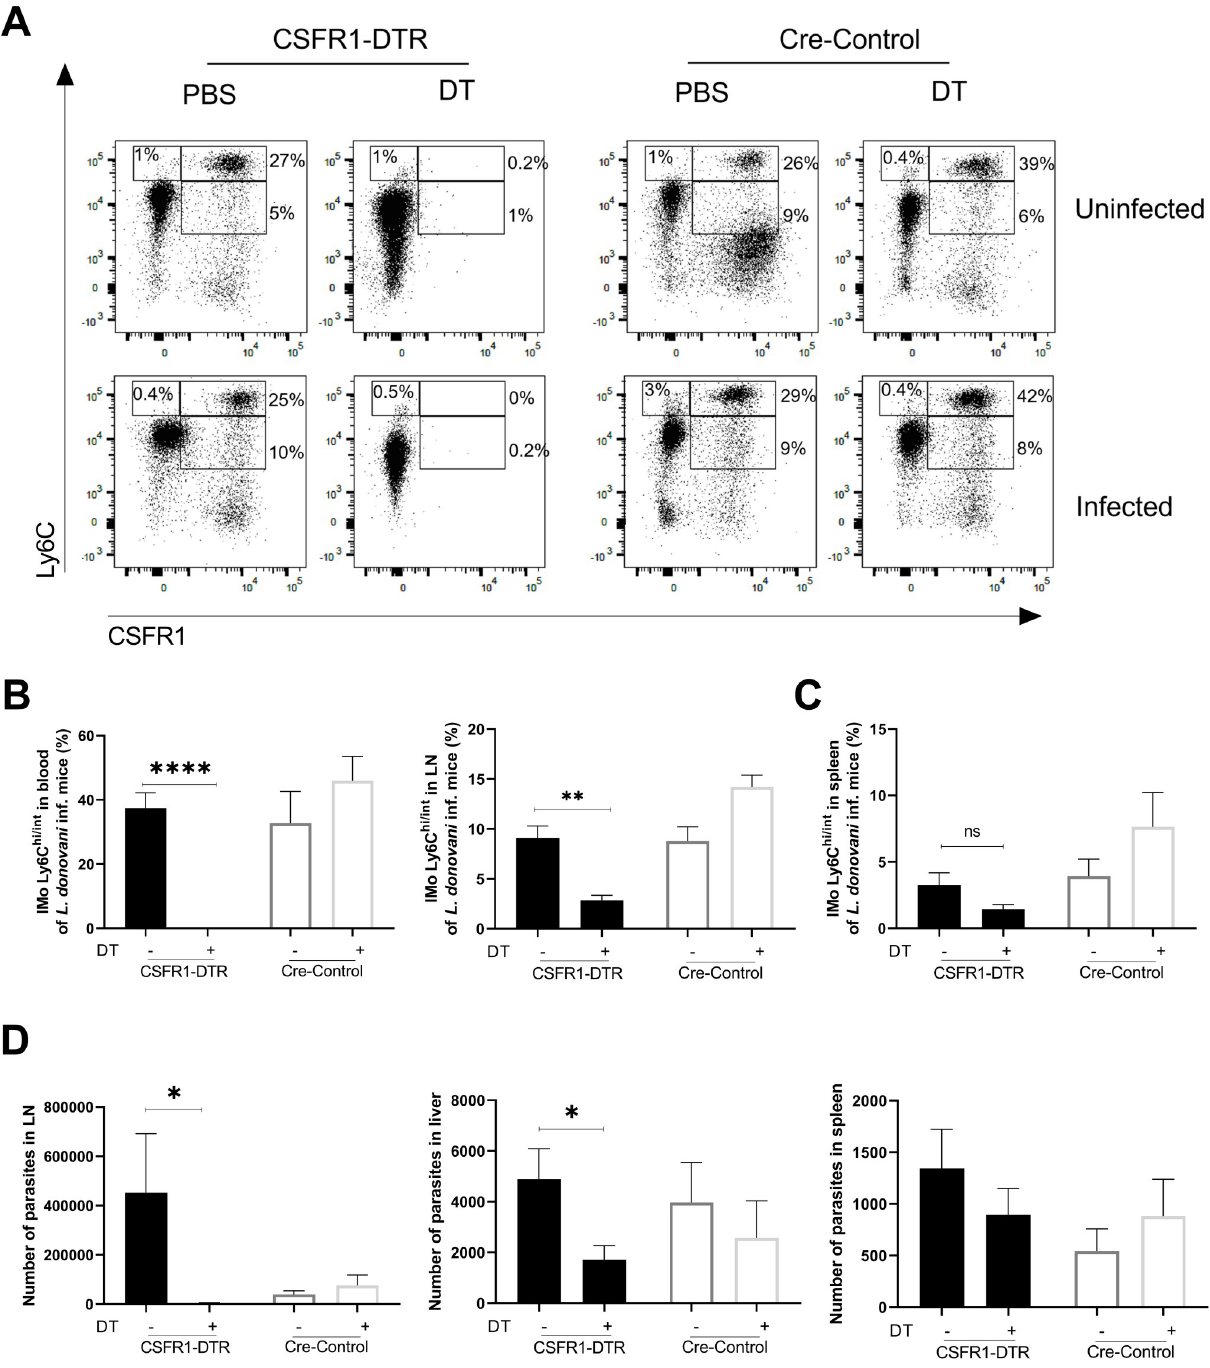
Fig 8. Depletion of inflammatory monocytes reduces early L . donovani visceralization in malnourished mice. Peripheral blood inflammatory monocytes in malnourished mice transgenic for diphtheria toxin receptor (CSFR1-DTR) and Cre-control malnourished mice were depleted or not by administration of diphtheria toxin (DT) or PBS. A. Representative flow cytometry dot-plots showing proportion of inflammatory monocytes in peripheral blood at 72h p.i. with L . donovani after administration of DT or PBS. N = 7–10 mice per group. B. Percent of Ly6C hi/int inflammatory monocytes in peripheral blood and lymph node (LN) of L . donovani -infected mice with (+) or without (-) administration of DT. ���� p < 0.0001; �� p = 0.0087 (Mann-Whitney test). N = 3–6 mice per group. C . Partial depletion of inflammatory monocytes Ly6C hi/int in spleen of L . donovani -infected mice with (+) or without (-) administration of DT. N = 7–10 mice per group. D . Number of parasites (determined by qPCR) in the lymph node (LN), and visceralizing to liver and spleen 72 hr after intradermal L . donovani infection and depletion of peripheral blood inflammatory monocytes with DT in DTR or Cre-control malnourished mice. LN: � p = 0.046 (Mann-Whitney test); Liver: � p = 0.028 (Unpaired t-test). N = 6–13 mice per group.